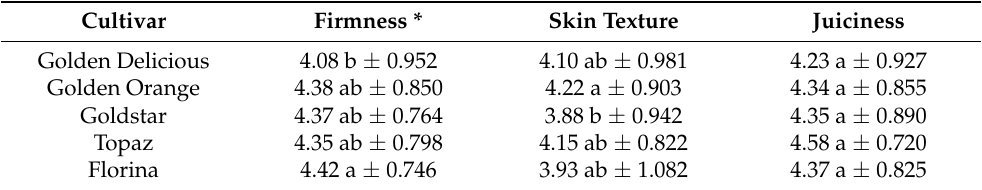
Table 3. Consumer evaluation of the fruit of five apple cultivars for texture quality attributes— firmness, skin texture and juiciness (mean ± standard deviation).